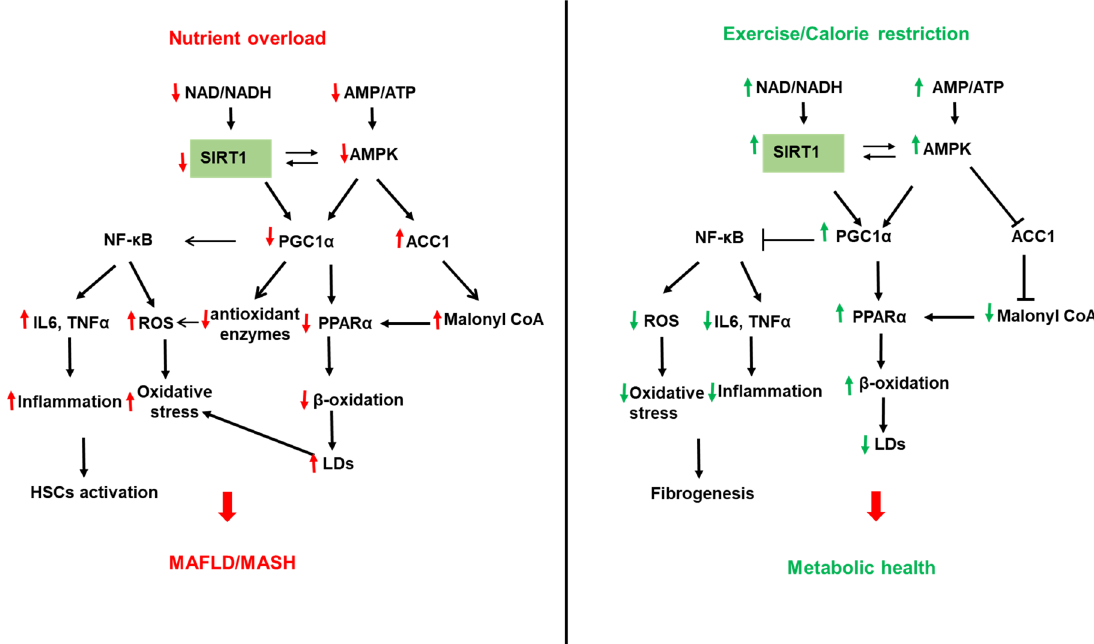
Figure 2. Role of sirtuin (SIRT) 1 in NAFLD. Left panel: Reduced SIRT1 with nutrient overload leads to the acetylation and inactivation of the peroxisome proliferator-activated receptor (PPAR) gamma- coactivator α (PGC1 α ). Reduced PGC1 α activity downregulates β -oxidation by reducing PPAR α expression and decreasing mitochondrial biogenesis, leading to increased lipid accumulation in LDs and hepatic steatosis. In addition, reduced SIRT1 activity decreases the expression of the antioxidant enzymes (SOD2 and catalase), leading to increased cellular ROS. On the other hand, reduced PGC1 α activity increases the expression of the transcription factor NF- κ B to increase inflammatory cytokines such as TNF α and IL6 and ROS generation. In addition, reduced AMP/ATP ratio with nutrient overload inactivates AMP-activated protein kinase (AMPK), leading to reduced NAD/ATP ratio and reduced SIRT1 and PGC1 α activities. AMPK also directly regulates PGC1 via modulation of its phosphorylation. Reduced AMPK also reduces ACC1 phosphorylation and increases its activity leading to increased malonyl CoA and inhibition of β -oxidation. Right panel: Upregulation of SIRT1 by exercise, calorie restriction, and fasting upregulates SIRT1 leading to a healthier liver via opposite effects on B-oxidation, inflammation, and ROS generation than chronic nutrient